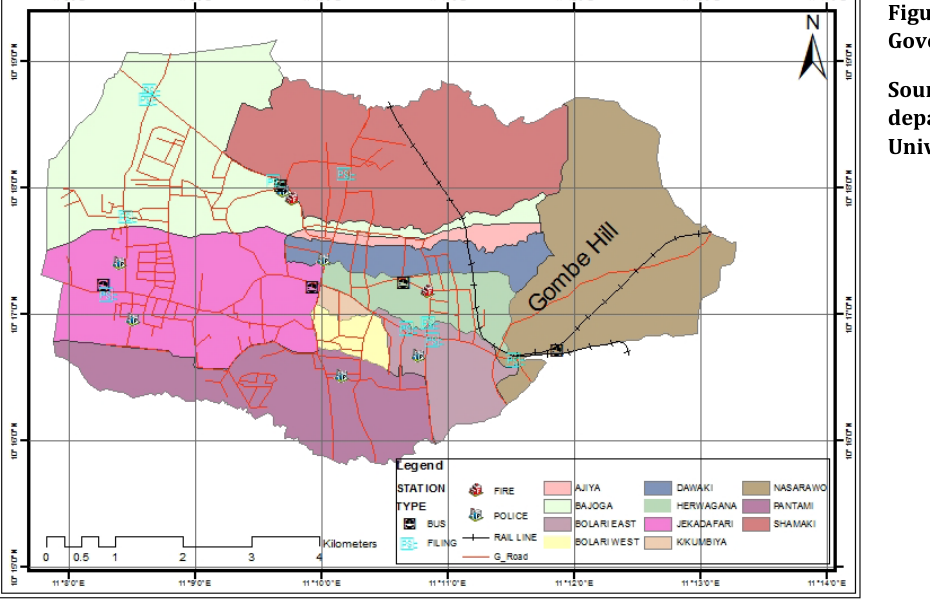
Figure 1. A map of Gombe Local Government Area Source: GIS Laboratory,